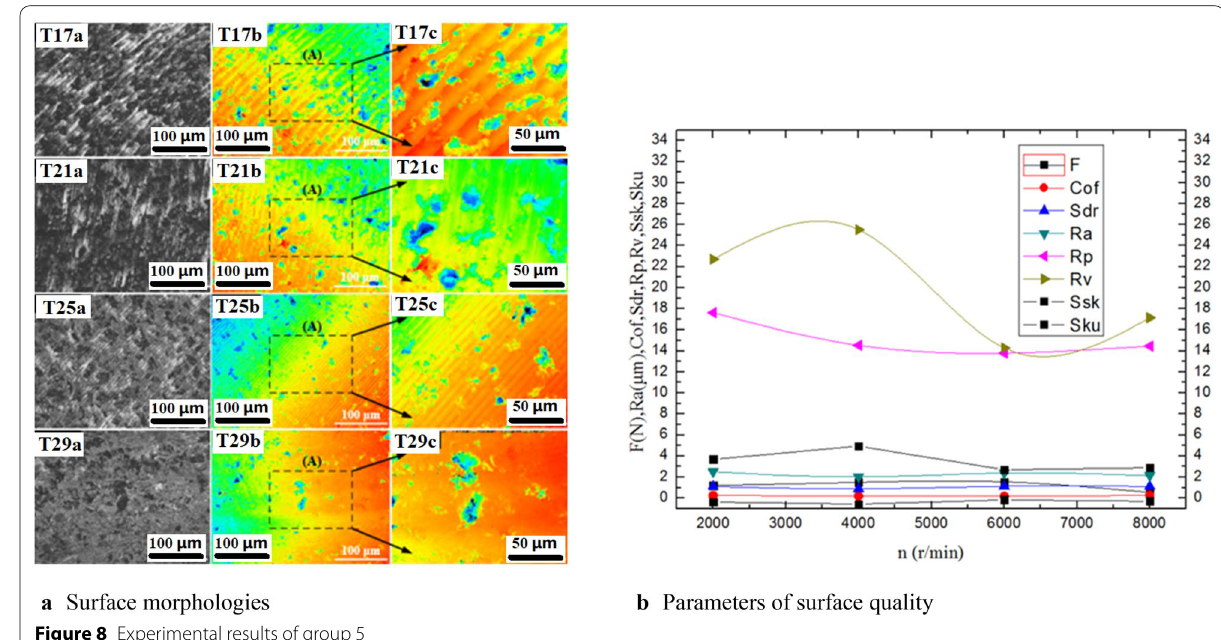
Figure 8 Experimental results of group 5